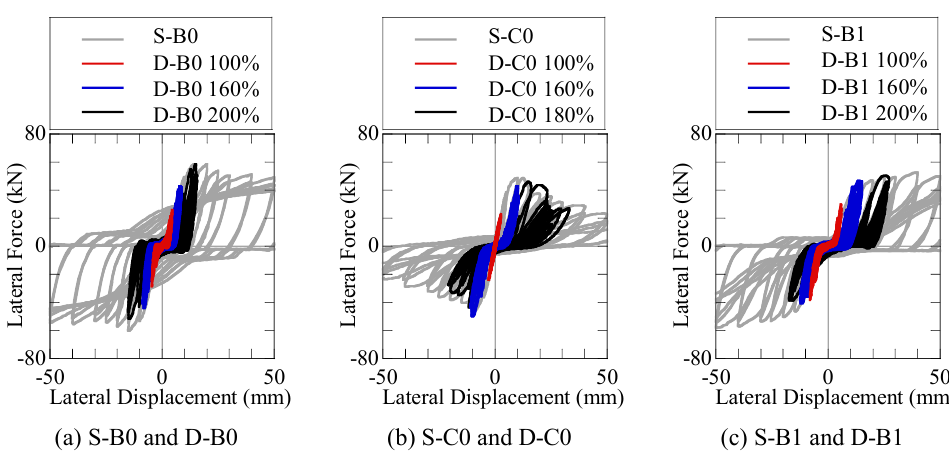
Figure 5. Lateral force and lateral displacement relationships based on the static and dynamic